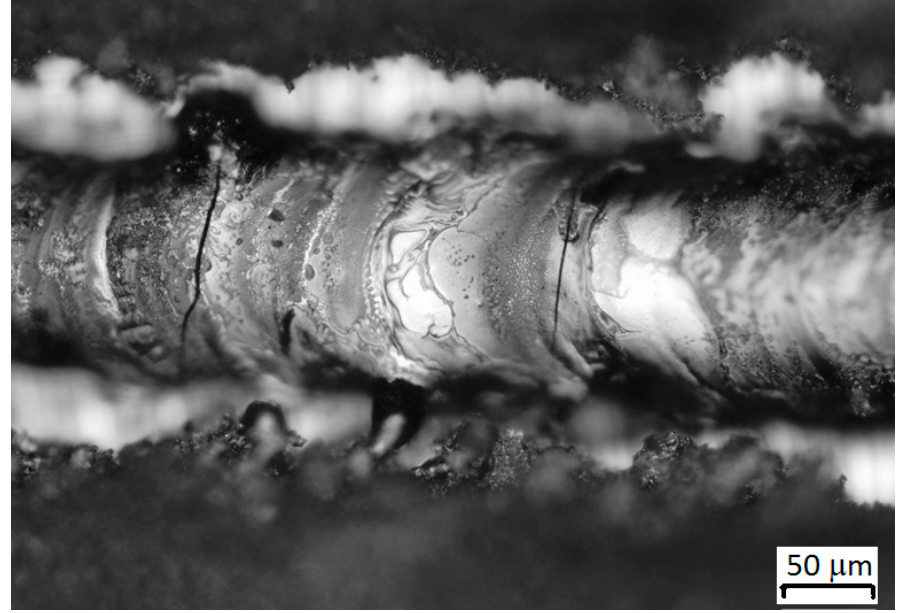
Figure 7. Cracks on the surface of a single track—94 wt% WC and 6 wt% Co P = 120 W, V = 300 mm/s. Materials 2019 , 12 , x FOR PEER REVIEW